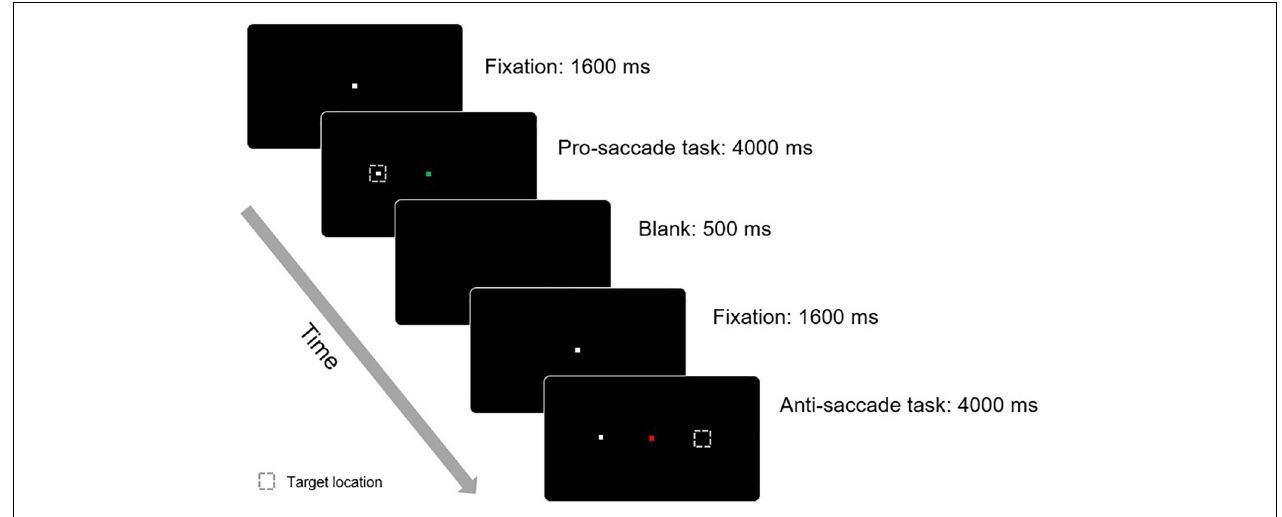
FIGURE 2 | Design of anti-saccade